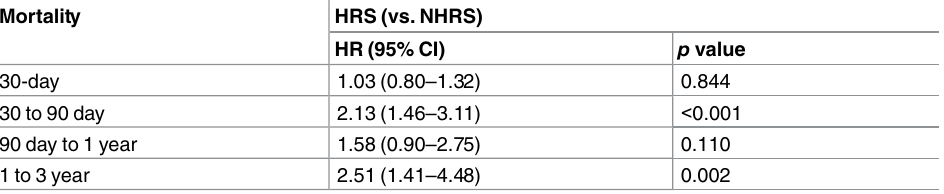
Table 5. Adjustedhazard ratiosof hepatorenalsyndromegroup for the 30-day, 30 to 90-day, 90-day to 1-year, and 1 to 3-year mortalityof cirrhoticpatientswithacuterenalfailure,compared to non-hepa- torenalsyndromegroup.